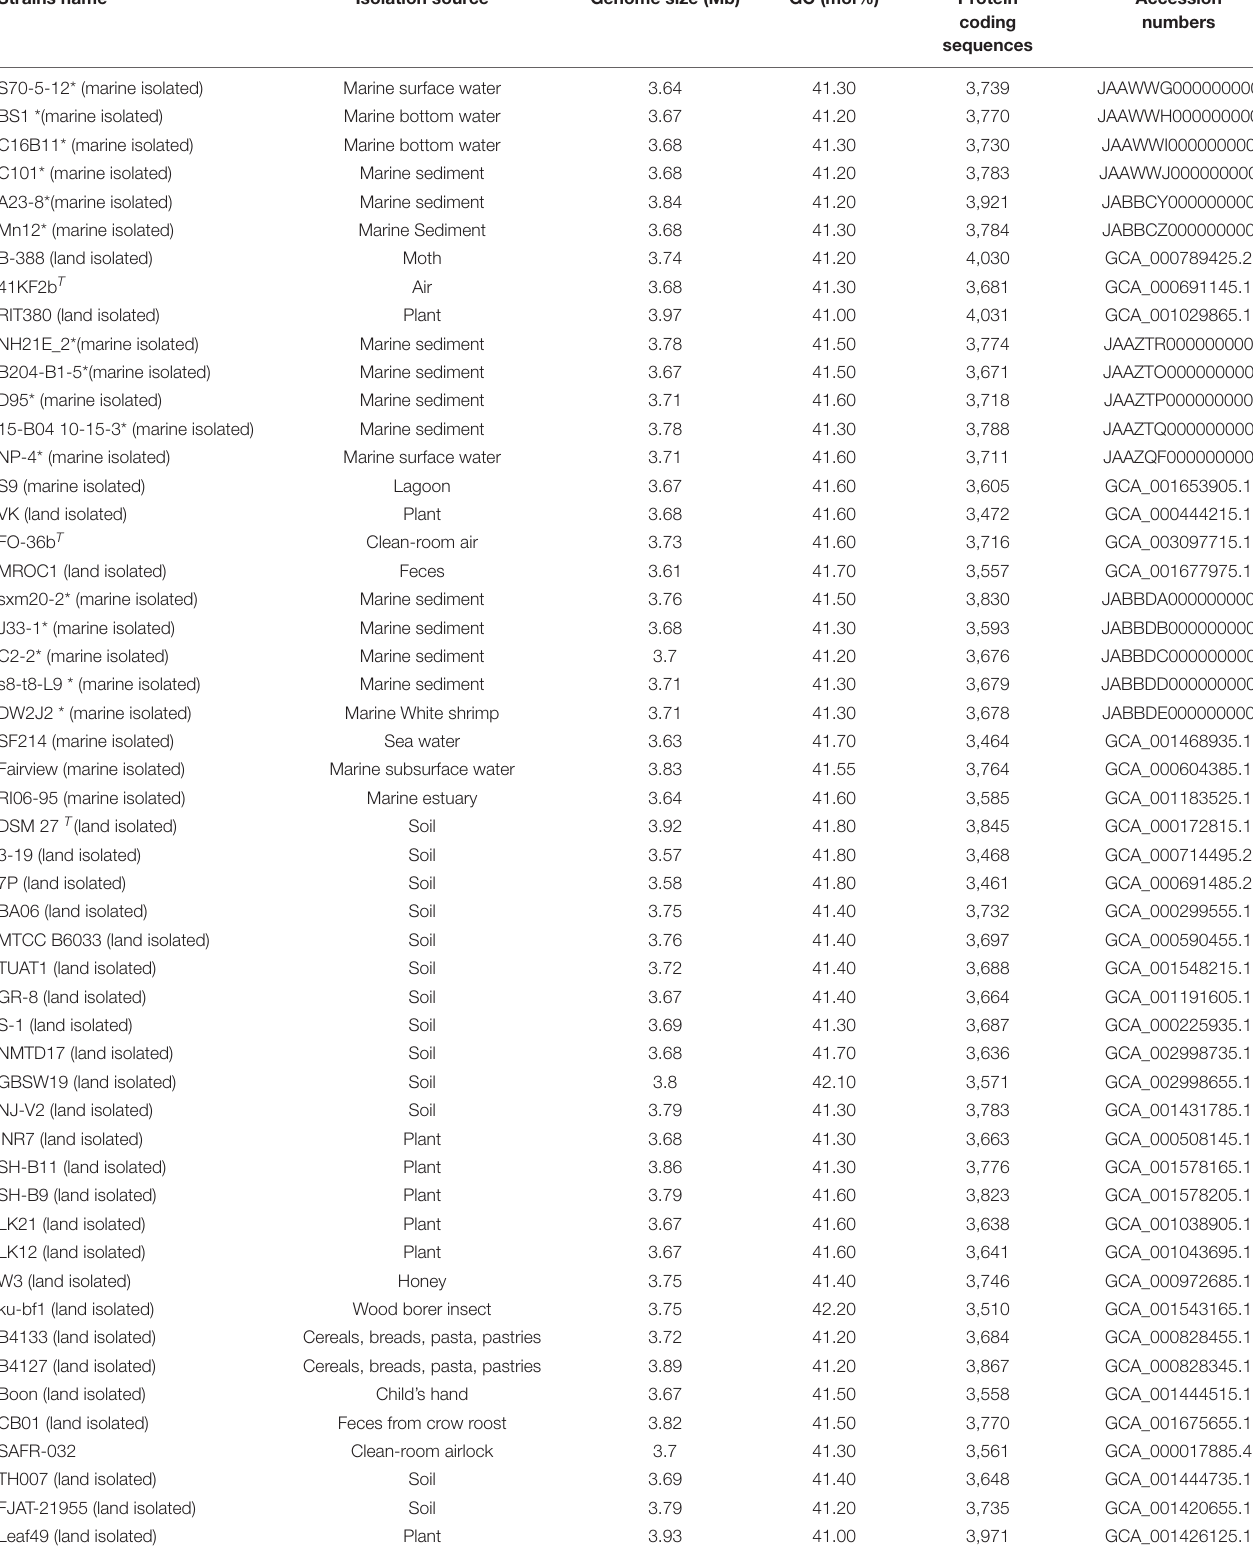
TABLE 1 | Genome information of Bp -group strains (*indicates strains that we isolated and